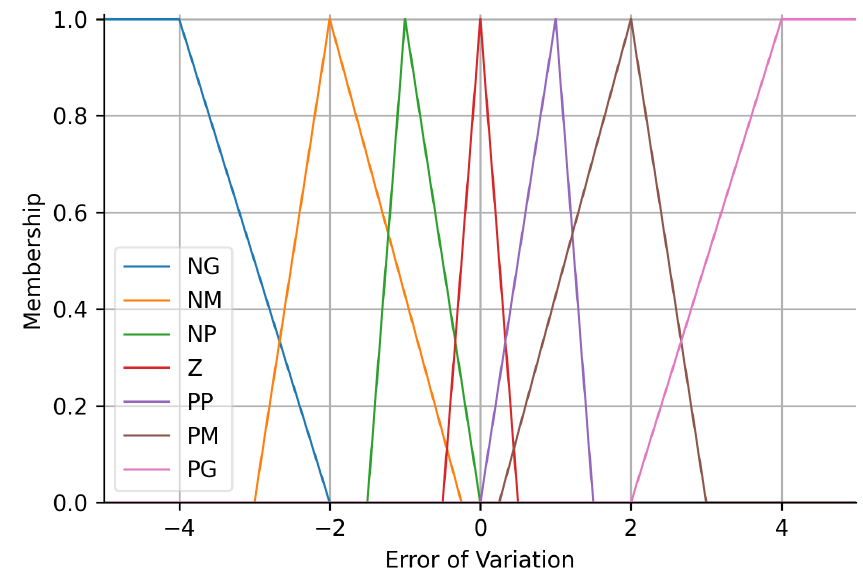
Figure 4. Membership function of the error (input variables).